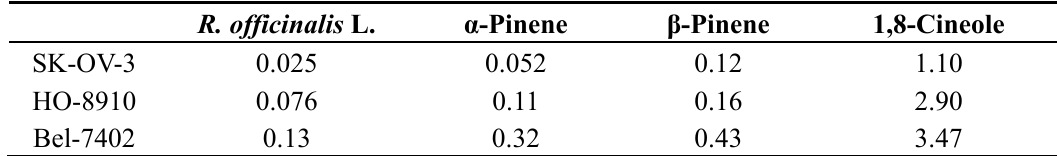
, ‰ v/v) values for Rosmarimus officinalis 50